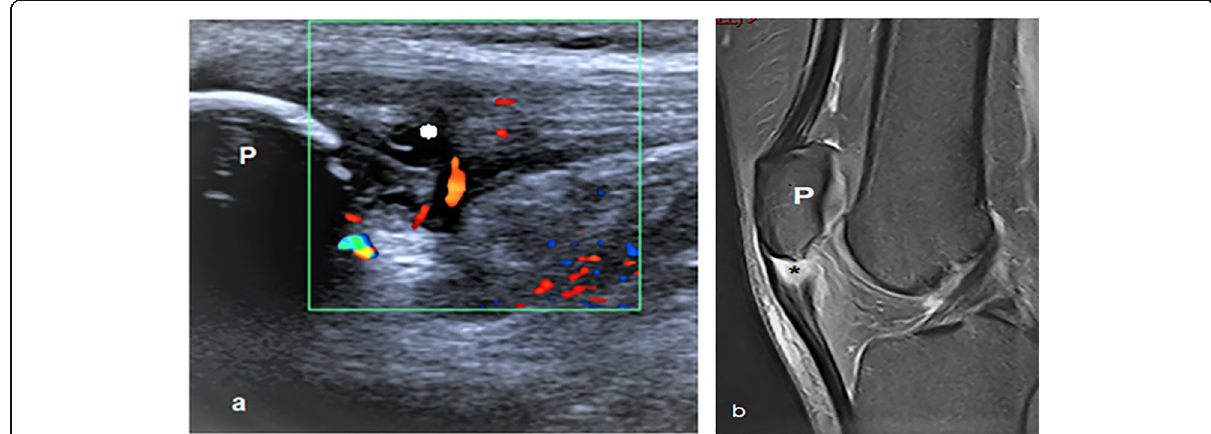
Fig. 9 A 22-year-old male with left patellar tendinopathy. a Long axis ultrasound image demonstrates the thickened proximal part of the patellar tendon with cystic changes (*). Color Doppler mapping shows increased vascularity in and around the tendon. b Sagittal PDFS shows thickened proximal patellar tendon with fluid signal (*). P,